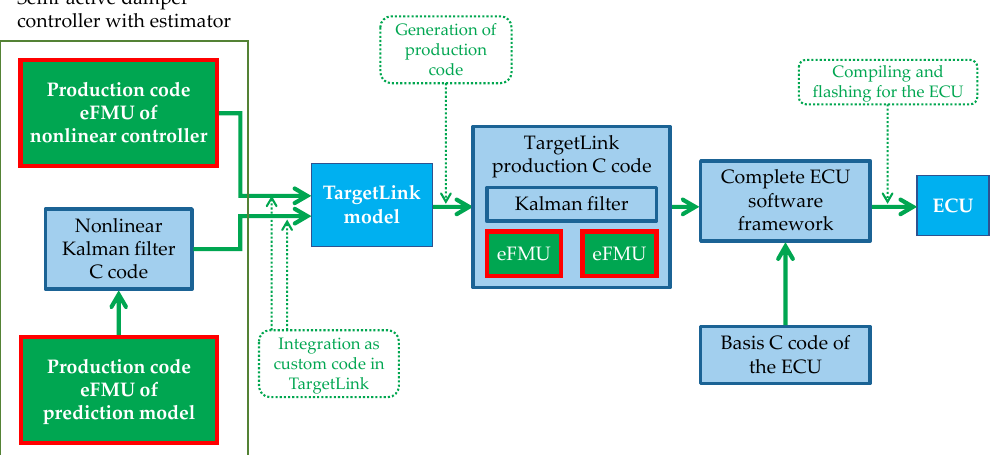
Figure 8. Integration of the 2 eFMUs into the ECU software framework.